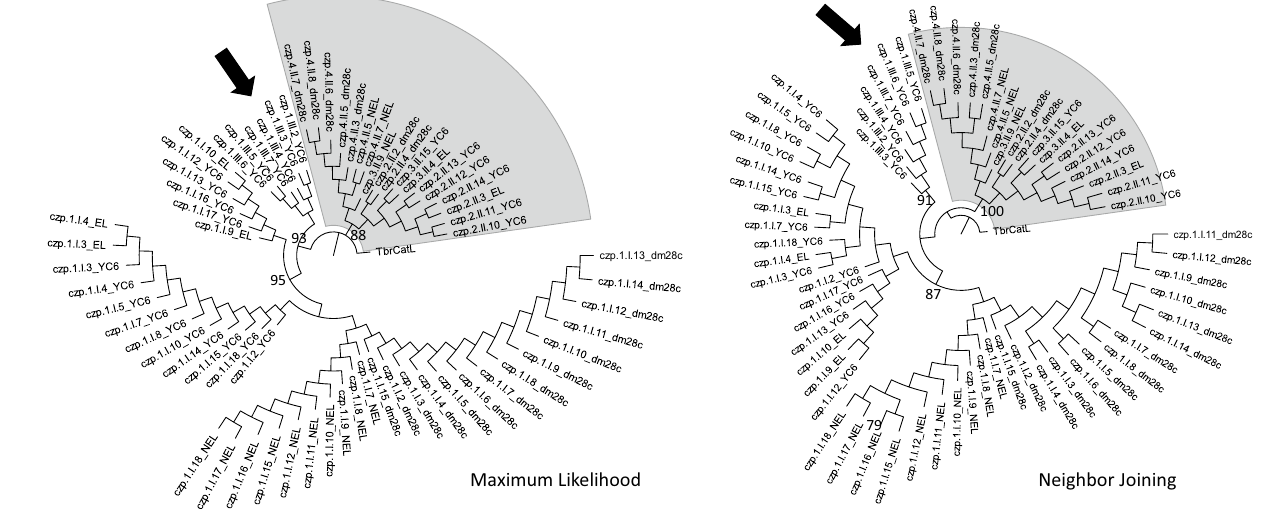
Figure 2. Phylogenetic analysis supports the division of cruzipain sequences into two families. The MEGA-X program was used to construct Maximum Likelihood and Neighbor Joining trees based on aligned amino acid sequences of the central domains of 67 genes encoding cruzipains in Dm28c, CL Brener, and YC6 T. cruzi strains. The numbers at the nodes are the bootstrap values, which were calculated based on 1000 replicates. Cruzipain sequences from Family II are highlighted in gray, and the arrows indicate the cruzipain sequences from Cluster III of the YC6 strain. The sequence of Tbr CatL (a.k.a. rhodesain, GenBank: CAC67416.1), the papain-like cysteine protease from Trypanosoma brucei , was used as